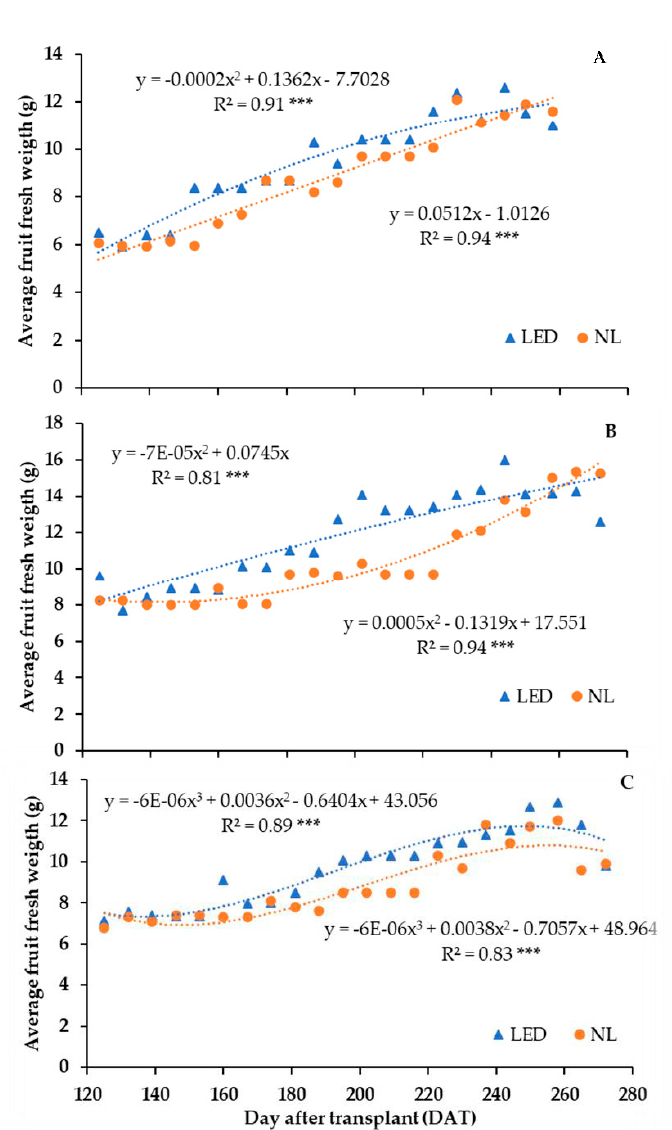
Figure 6. Relationship between average fresh fruit weight and days after transplant (DAT). Each symbol represents the mean of six replications for ‘Solarino’ ( A ) and ‘Sorentyno’ ( B ) and of eight replications for ‘Juanita’ ( C ). Different symbols and colors represent different light treatments. Regression equations and R 2 coefficients are presented. *** indicates significance at p ≤ 0.001.